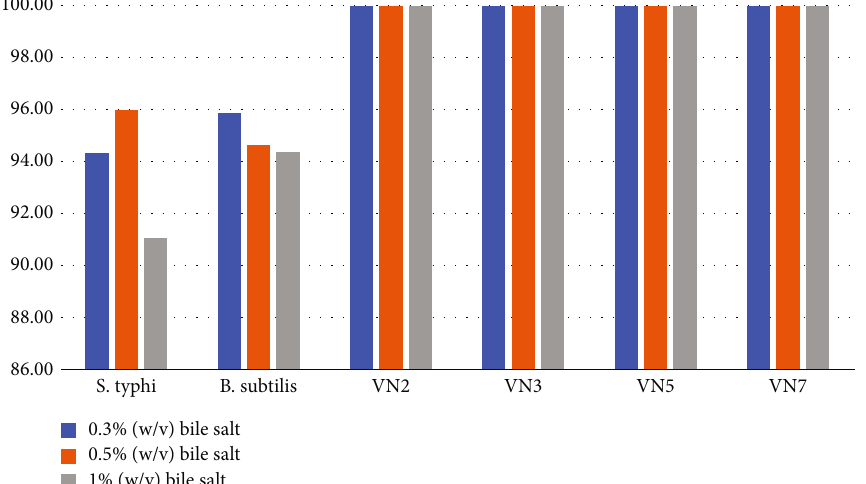
Figure 8: Bile tolerance activity.